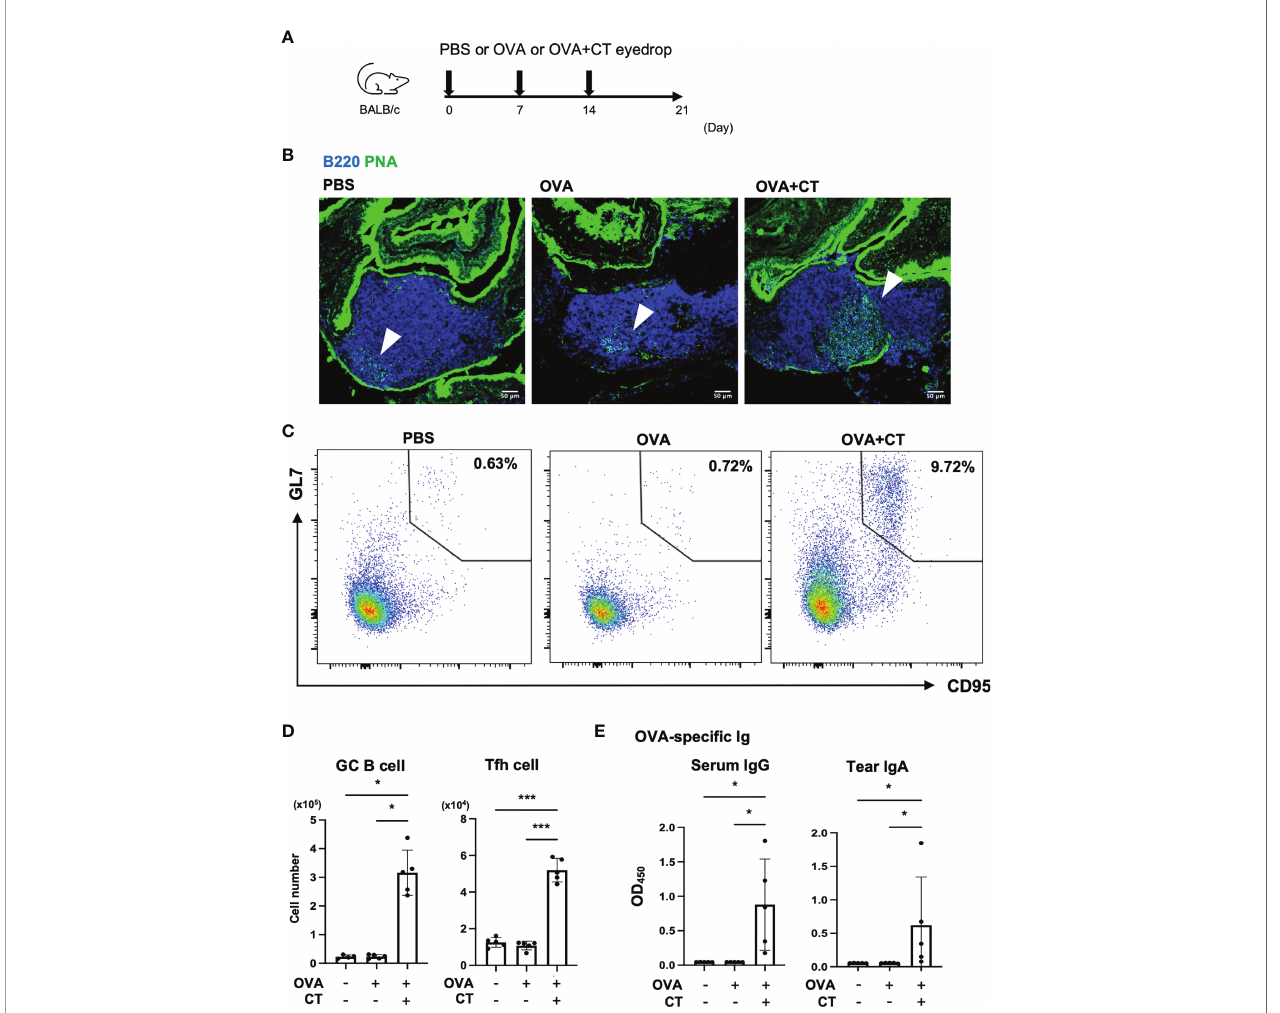
FIGURE 6 | Eye drop instillation of ovalbumin with cholera toxin adjuvant elicits a germinal center reaction in TALT and draining lymph nodes. (A) Immunization scheme of eye-drop immunization of BALB/c mice with PBS, OVA, or OVA with CT. (B) Confocal microscopic analysis of TALT sections stained with a lectin, PNA (green), and anti-B220 antibody (blue). Arrowheads show germinal center (PNA + B220 + cells). Bars: 50 µm. (C) Expression of CD95 and GL7 on TALT cells pooled from the 4 or 5 mice. Numbers in outlined areas show the percent of germinal center (GC) B cells (CD95 + GL7 + cells) in CD3e - B220 + lymphocytes in TALT. (D) The number of GC B cells and Tfh cells (CXCR5 + PD-1 + in CD4 + CD8 - T cell) in the cervical and submandibular lymph nodes (cLN and smLN) was quanti fi ed by fl ow cytometry at 1 week after the fi nal immunization. Gating strategies for the fl ow cytometry analyses were shown in Supplementary Figure 7 . (E) OVA-speci fi c serum IgG levels and tear IgA levels were measured by ELISA. Data were obtained from a single experiment. Bars represent the mean ± standard deviation. *** P < 0.001, * P < 0.05 (GC B cell, OVA-speci fi c serum IgG and tear IgA: Kruskal-Wallis test, Tfh cell: one-way ANOVA by Tukey ’ s test, PBS: n = 4 or 5, OVA: n = 5, OVA + CT: n = 5